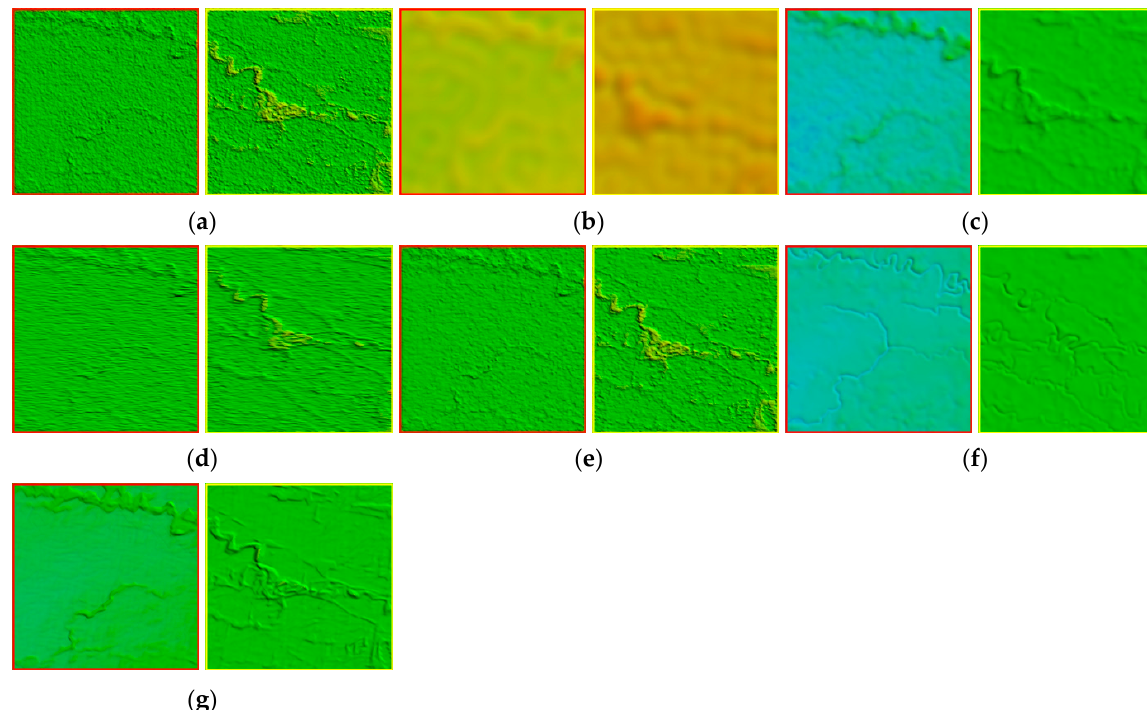
Figure 15. Results of the real experiment for the local enlargement of area S36E144 (Figure 14). Local enlargements for ( a ) area S36E144, ( b ) low-pass filter, ( c ) TV, ( d ) UTV, ( e ) LRSID, ( f ) Gallant and ( g ) LRGS.